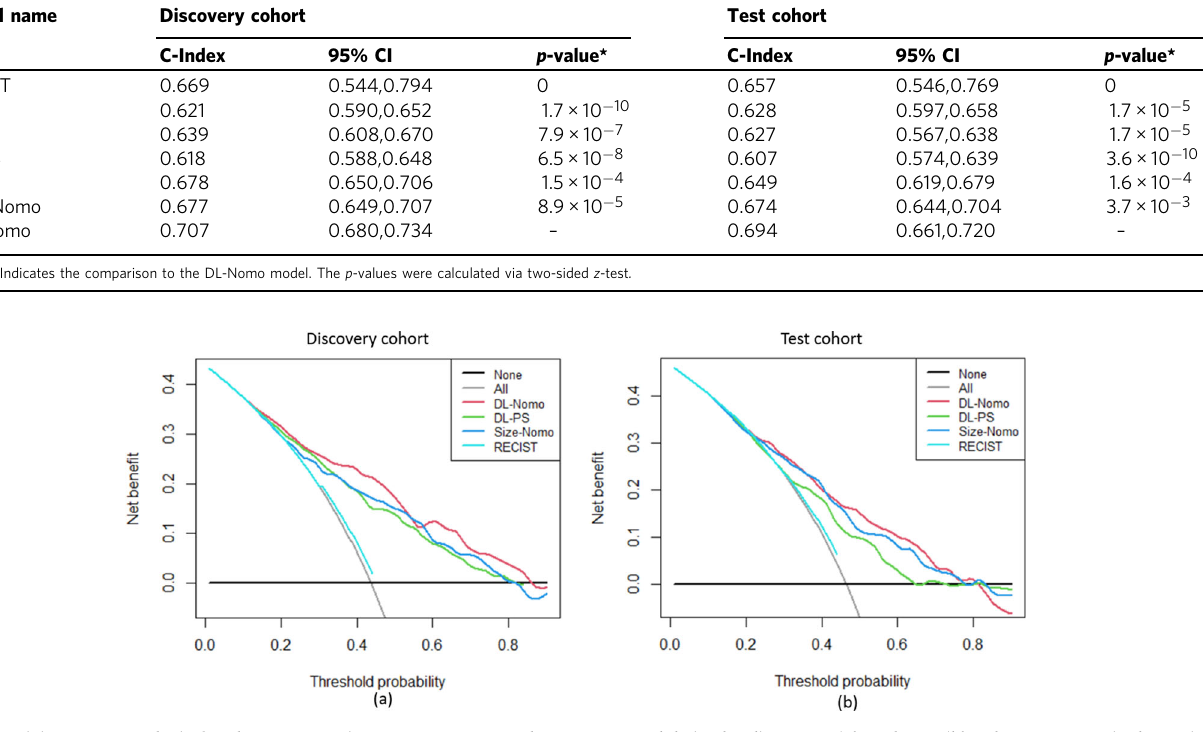
Fig. 5 Decision curve analysis for the RECIST, Size-Nomo, DL-PS, and DL-Nomo models in the discovery (a) and test (b) cohorts, respectively. In the fi gures, the y -axis measures the model bene fi t, and the x -axis shows the corresponding threshold. The model bene fi t is de fi ned as the percentage of patients whose 1-year survival status (alive/dead) are correctly predicted. And the threshold is the cutoff used by the model, which is with the range of zero to one. As shown in the fi gures, the DL-Nomo model shows the highest level of bene fi t across the range of thresholds in both the discovery ( a ) and test ( b )